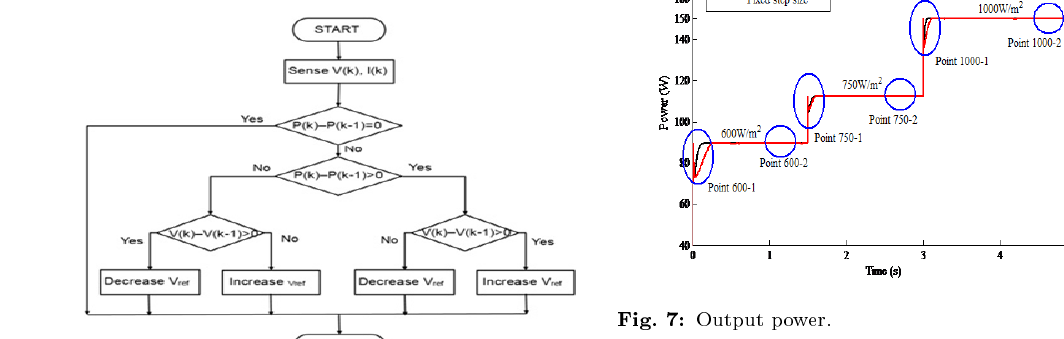
Fig. 7: Output power.